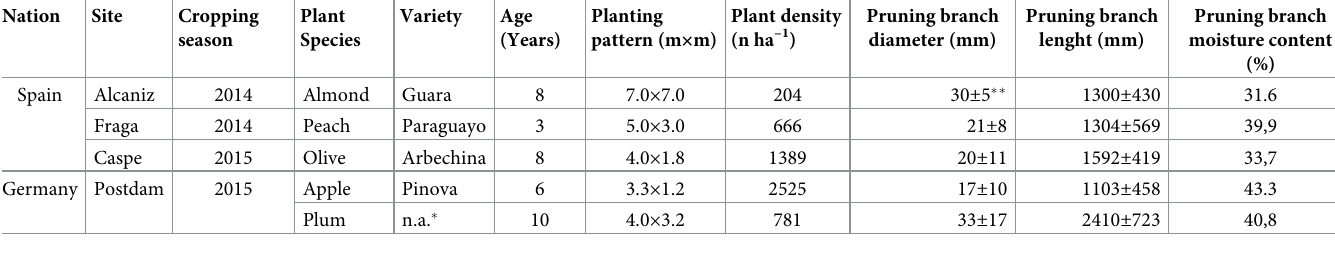
Table 1. Main parameters of orchard species used during the trials and pruning characteristics. Nation